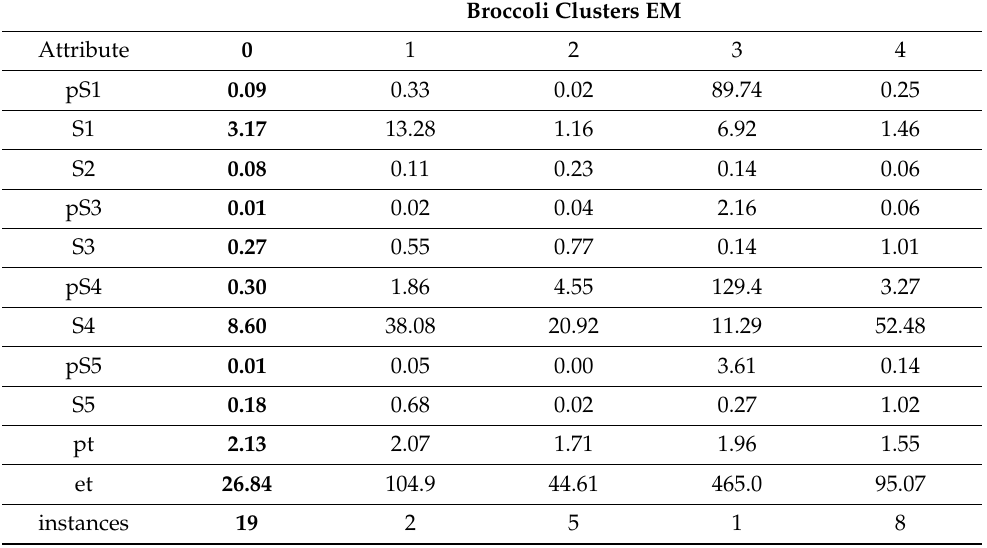
Table 8. EM clusterization of broccoli